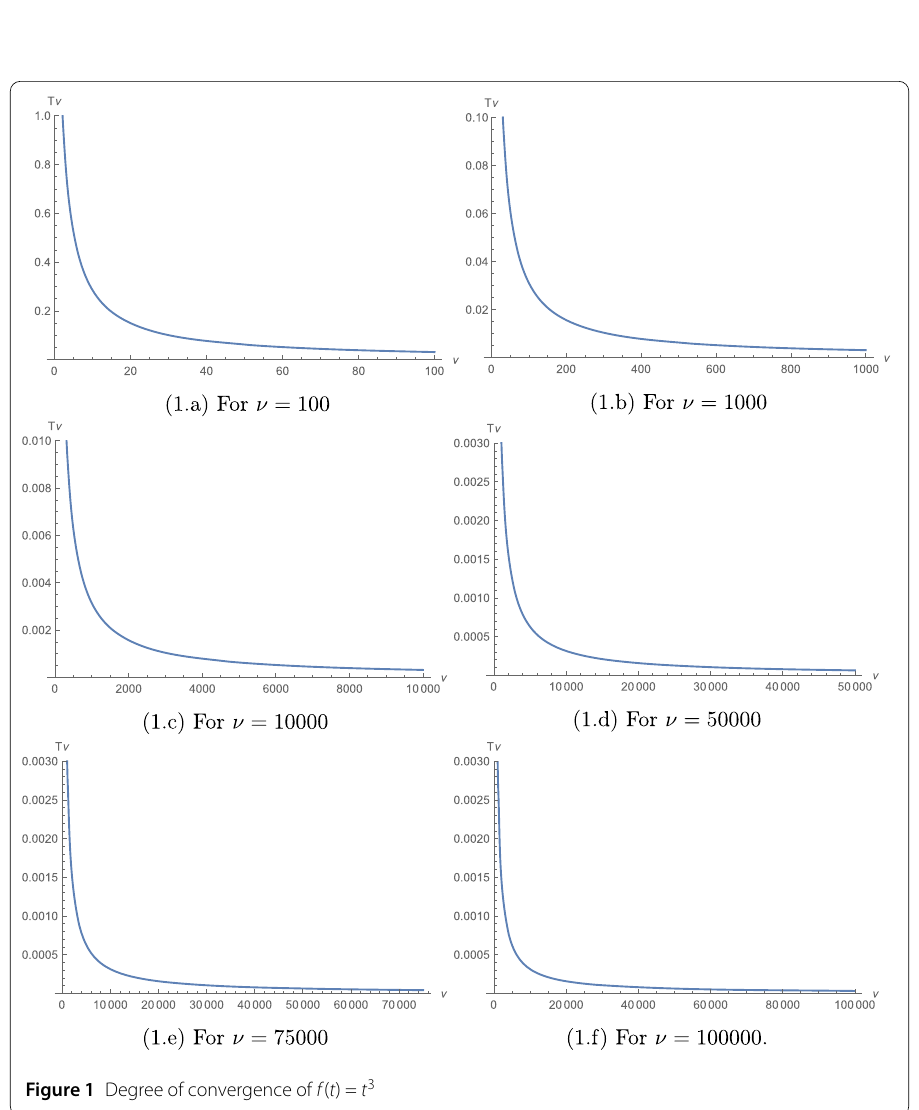
Figure 1 Degree of convergence of f ( t ) = t